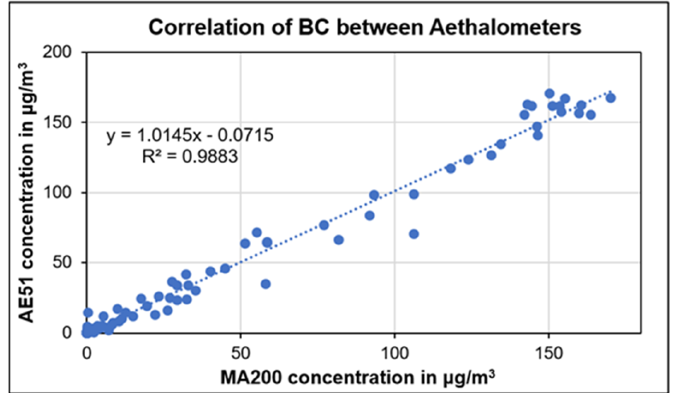
Figure 32. Correlation between BC aethalometers from AethLabs.